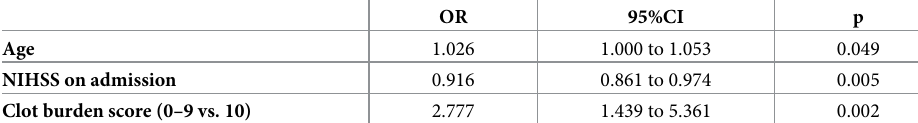
Table 3. Independent predictors of poor short-term outcome a in the studied